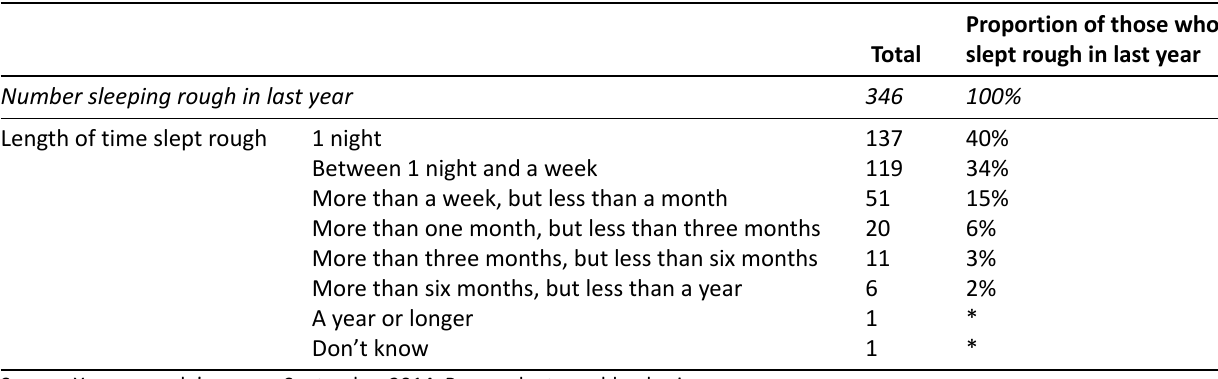
Proportion of those who